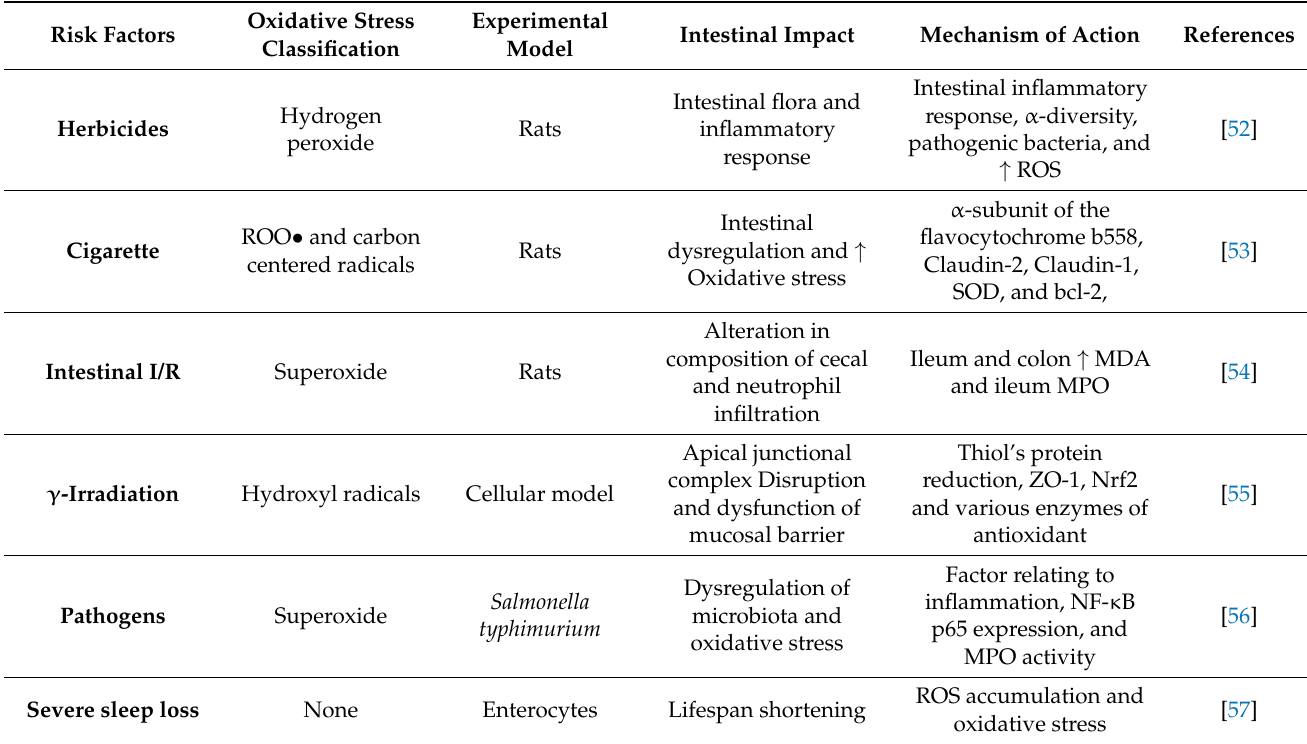
Table 1. Common risk factors of intestinal oxidative